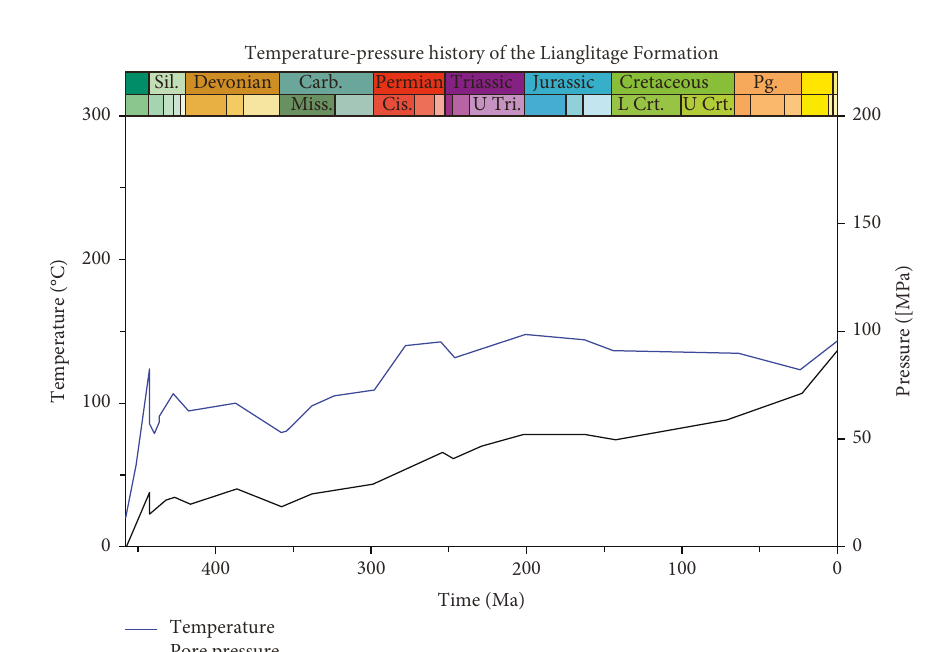
Figure 7: Temperature ( T ) and pressure ( P ) histories (upper) of the Lianglitage Formation (O